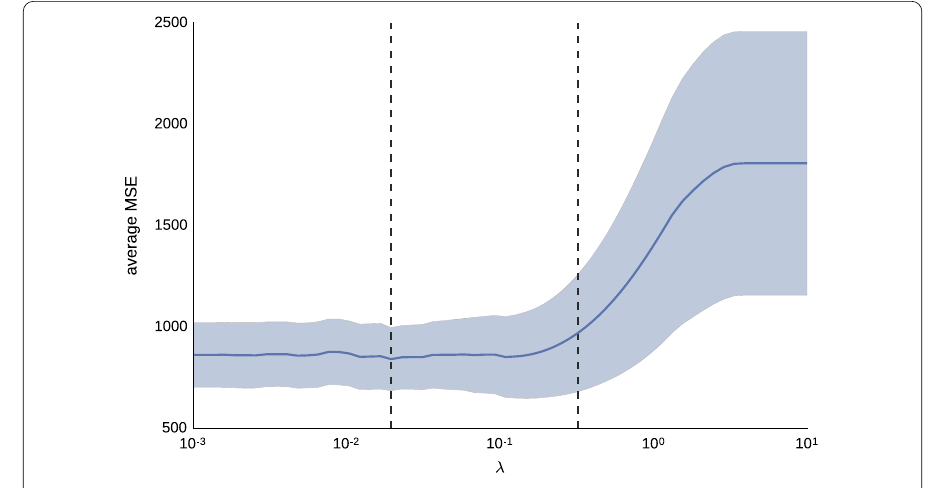
Figure 8 Cross-validation error. The average mean squared error (MSE) for different values of the regularization term λ . The right vertical line represents the value of λ selected with the one standard error rule, and the left one indicates the position of the